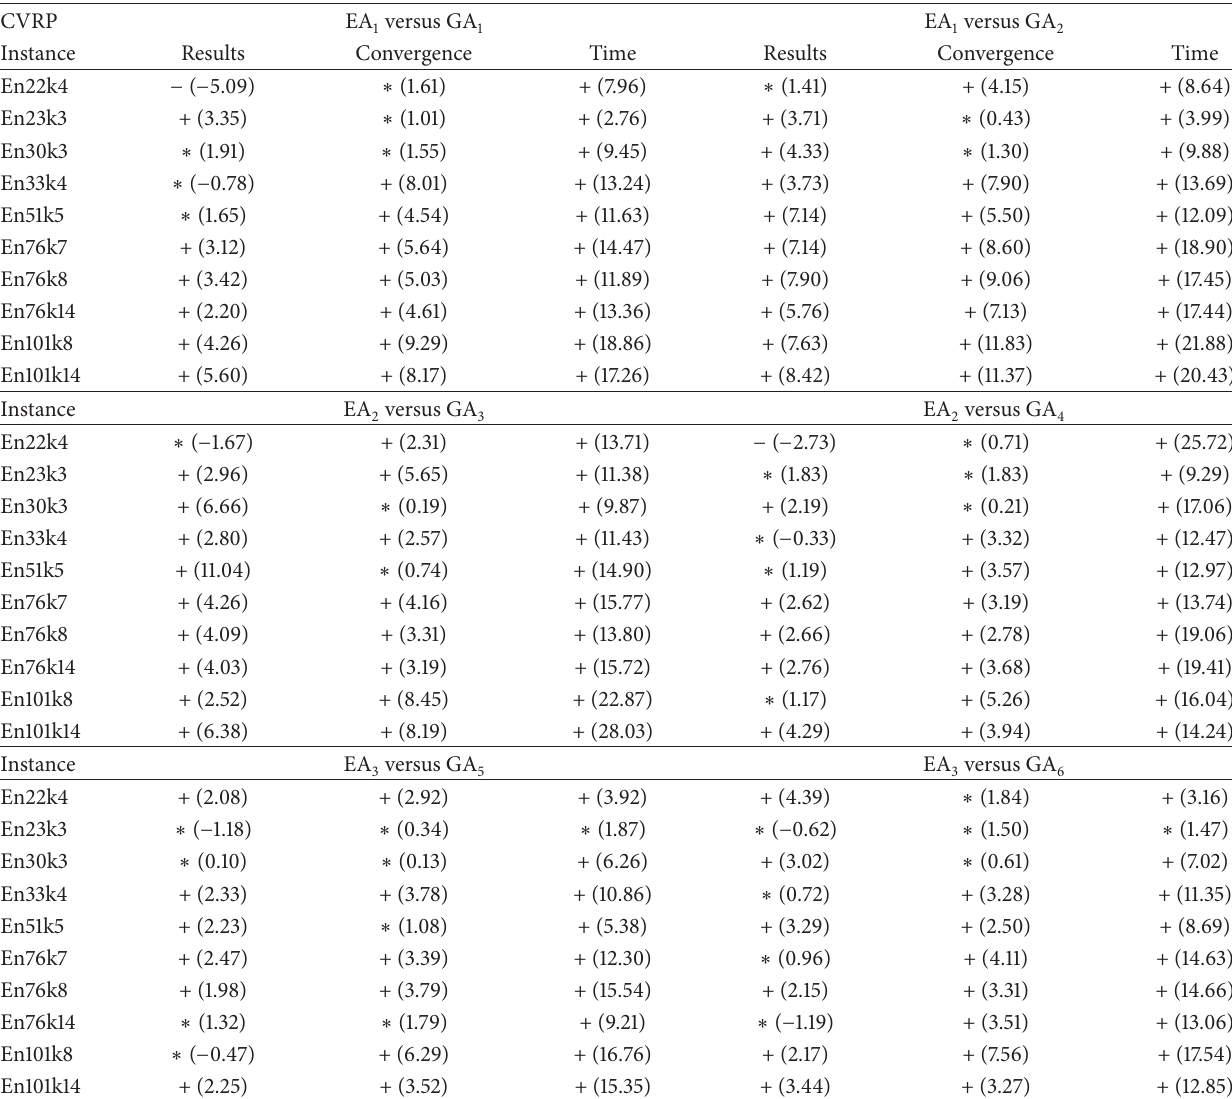
Table 7: 𝑧 -test for CVRP. “+” indicates that EA is better. “ − ” depicts that it is worse. “ ∗ ” indicates that the difference between the two algorithms is not significant (at 95% confidence